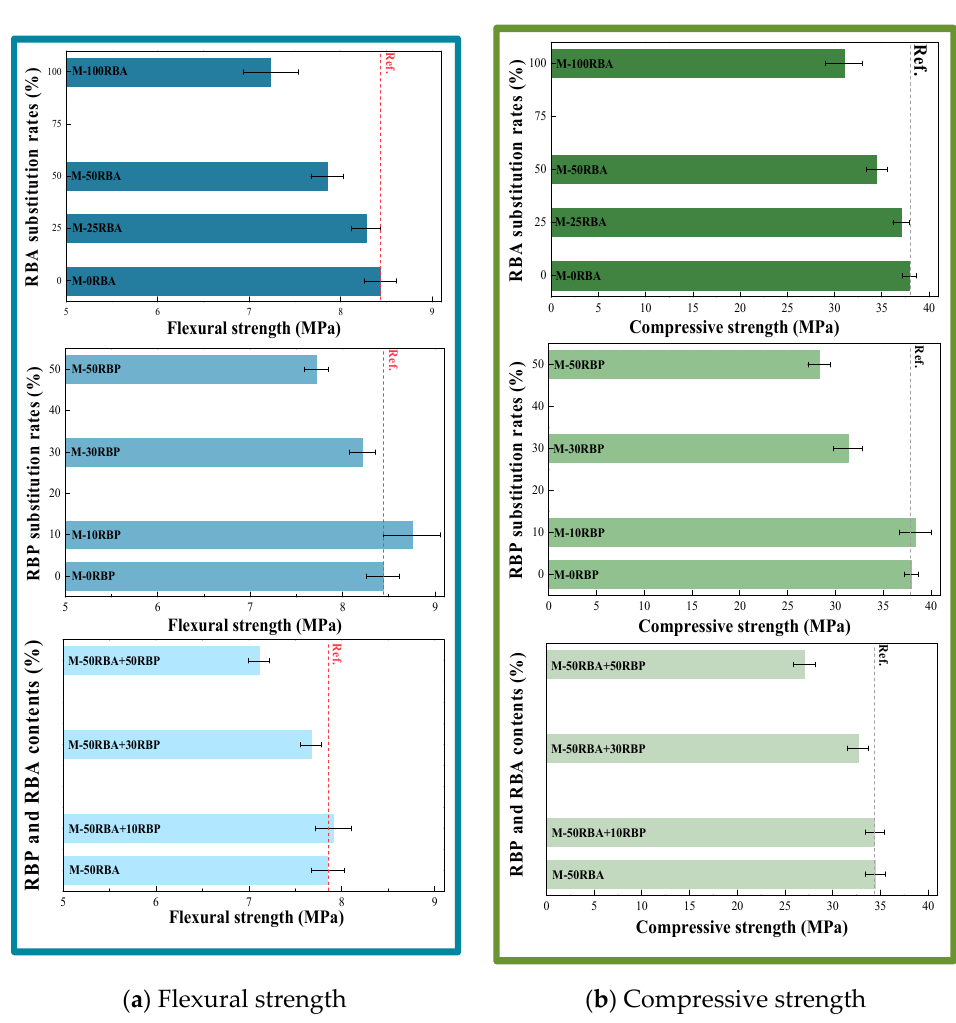
Figure 10. Mechanical strength of cement mortar with RBA and RBP.